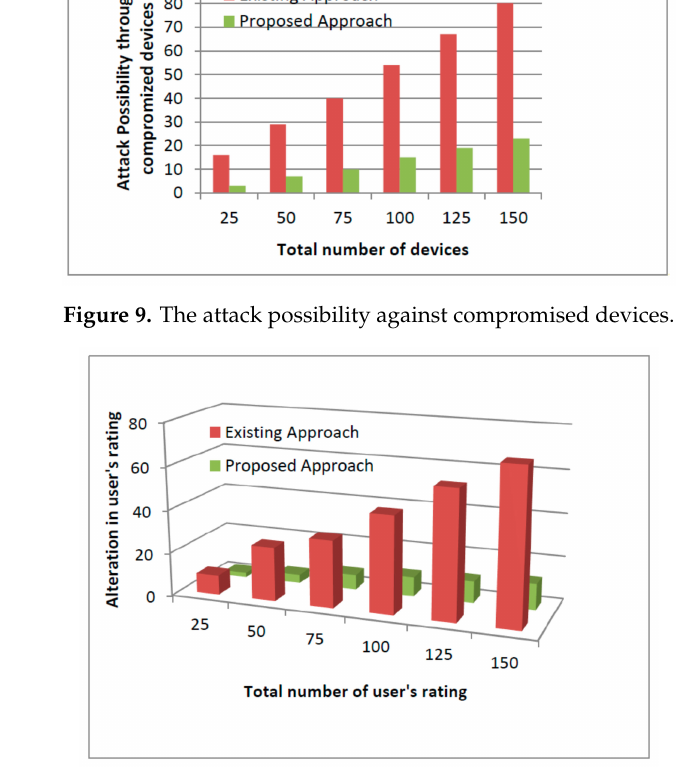
Figure 10. In user’s stored ratings by intruders.